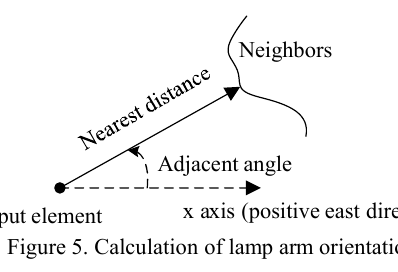
Figure 5. Calculation of lamp arm